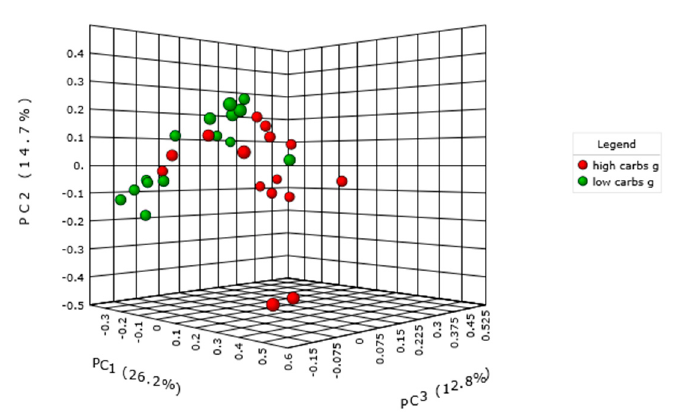
Figure 5. Intestinal microbiota diversity in children with ASD with high and low carbohydrates intake per day, p = 0.01.